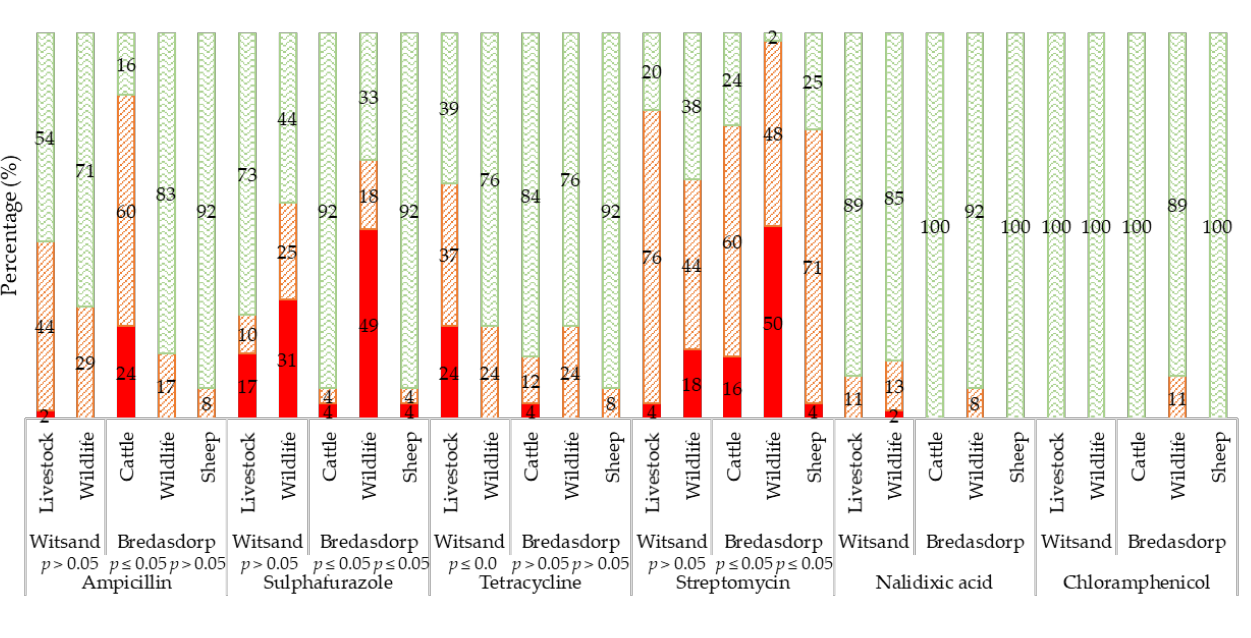
Figure 1. Antibiotic susceptibility patterns of E. coli -isolated sheep ( n = 5, N = 24) and cattle ( n = 5, N = 21) (livestock), and springbok ( n = 1, N = 3) and deer ( n = 4, N = 19) (wildlife) from a co-grazing farm (Witsand) and from sheep ( n = 5, N = 24), cattle ( n = 5, N = 25), eland ( n = 5, N = 24) and wildebeest ( n = 5, N = 22) (wildlife) from a non-co-grazing farm (Bredasdorp). n = number of animals tested, N = total number of isolates tested.